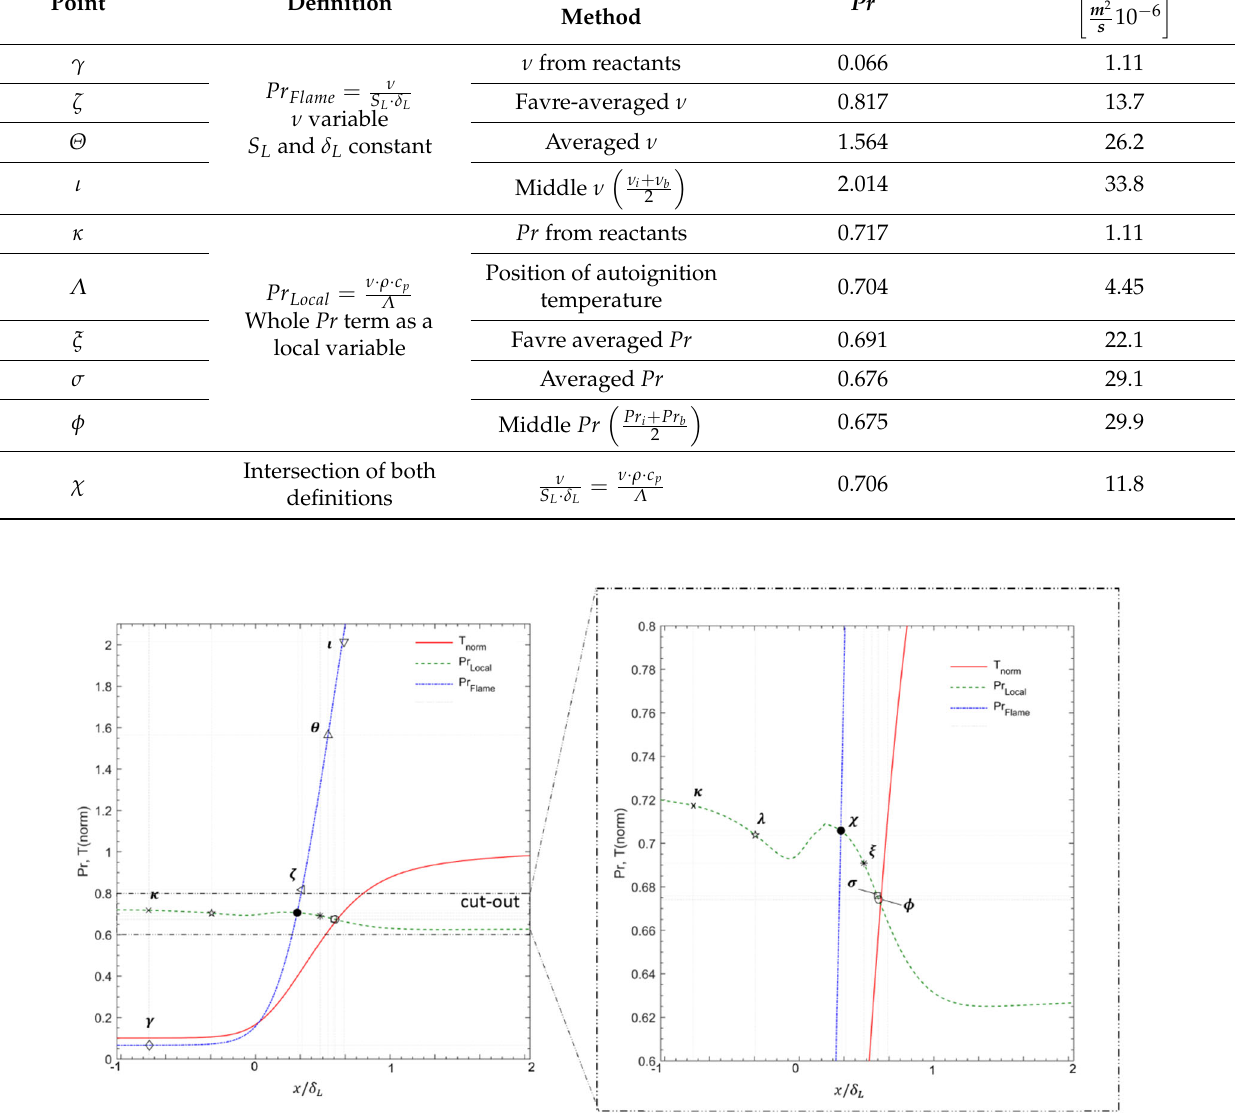
Table 2. Definitions of Pr in Figure 8